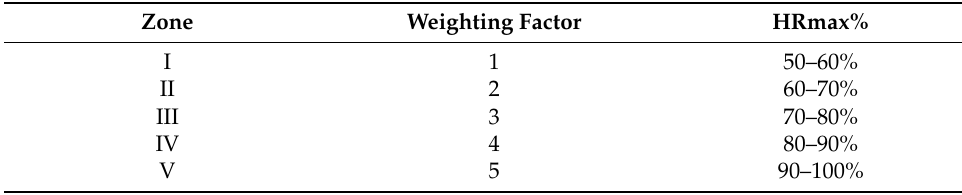
Table 3. HRmax% zones and corresponding weighting